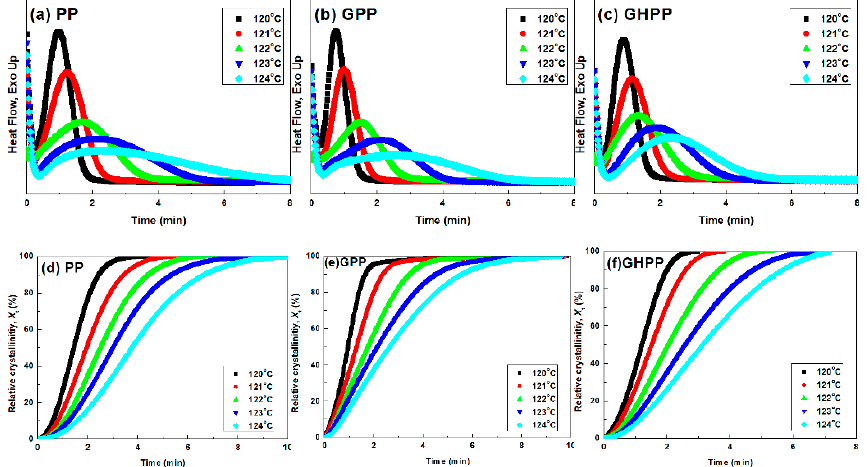
Figure 4. DSC isothermal crystallization curves and plots of relative crystallinity versus crystallization time for PP, GPP and GHPP at T cISO = 120–124 °C.